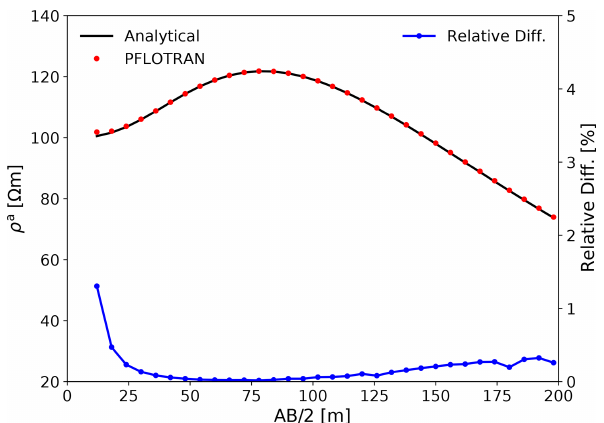
Figure 4. Apparent resistivity ρ a responses computed for the lay- ered earth resistivity model in Fig. 3 (upper plot). They are cal- culated using the analytical method (solid black lines) and PFLO- TRAN (filled red circles). The lower plot (blue line) shows the rel- ative difference (in percentage) between the analytical and PFLO- TRAN